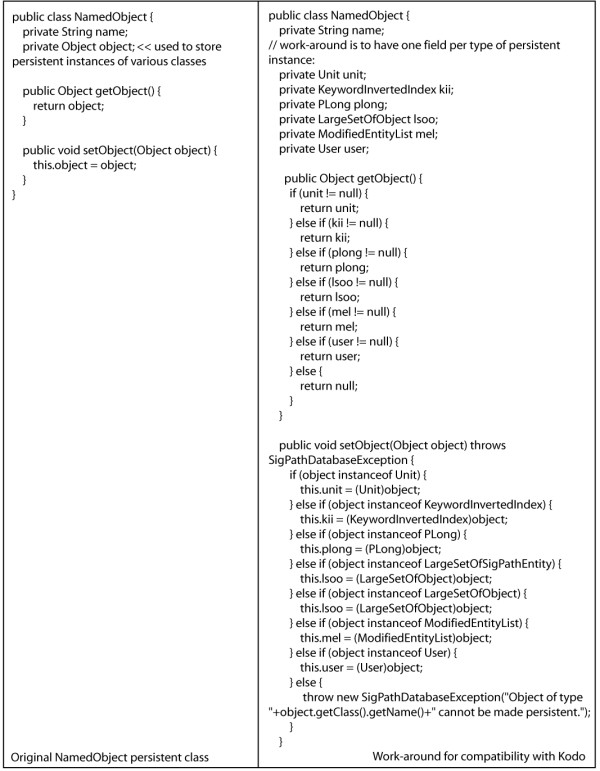
Work-around for classes that contain an object field.